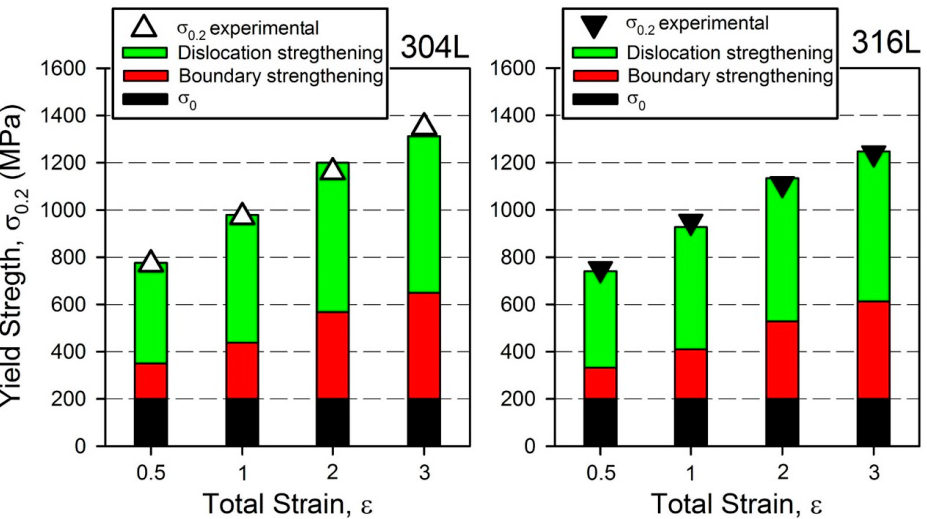
Figure 16. Contribution of different strengthening mechanisms to general yield strength of 304L and 316L stainless steels subjected to rolling at 473 K.